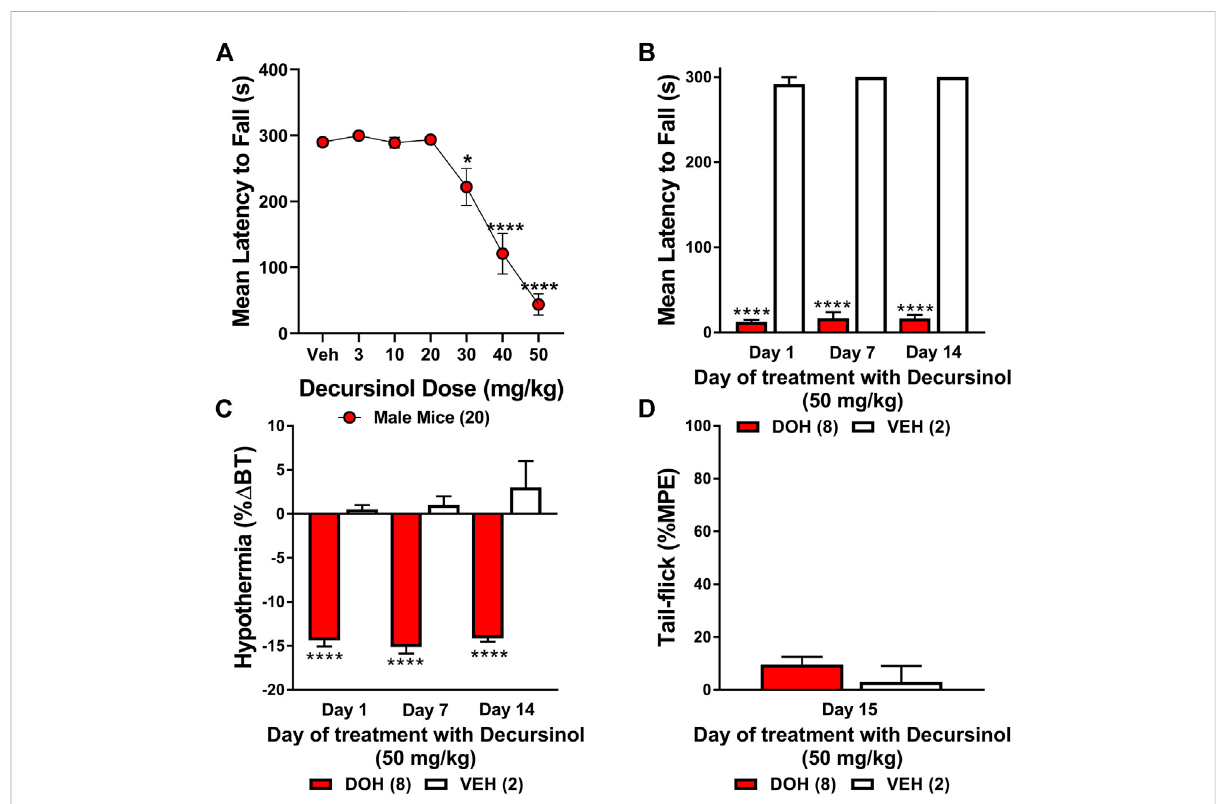
FIGURE 8 Decursinol-induced ataxia in male mice. Mice were assessed for the ataxic effects of decursinol (A) across a range of doses and tolerance to both the ataxic (B) and hypothermic (C) effects of decursinol to dissociate confounds of ataxia on tolerance to the antinociceptive effects of decursinol on tail- fl ick (D) . Using an accelerating rotarod, mice were assessed for the mean latency (in seconds) to fall 30 min post decursinol administrationontherotarod acrossdose (A) oron days 1,7,and14 across14 days ofonce-daily administration of 50 mg/kg decursinol (N=8; red bars) or vehicle (VEH; N = 2; white bars). Mice were also assessed for tolerance to hypothermia on days 1, 7, and 14 of decursinol administration (C) and on Day 15 to see if mice were tolerant to the antinociceptive effects of decursinol following 14 days of once-daily administration on the